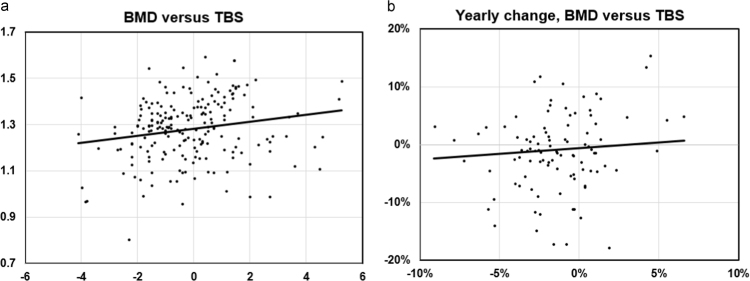
Correlations of BMD with TBS. A: Correlation of intra-patient BMD (lumbar spine) versus TBS at baseline; B: Correlation of changes in BMD versus TBS over time, calculated as annual rate of change. Legend: BMD, bone mineral density; TBS, trabecular bone score.